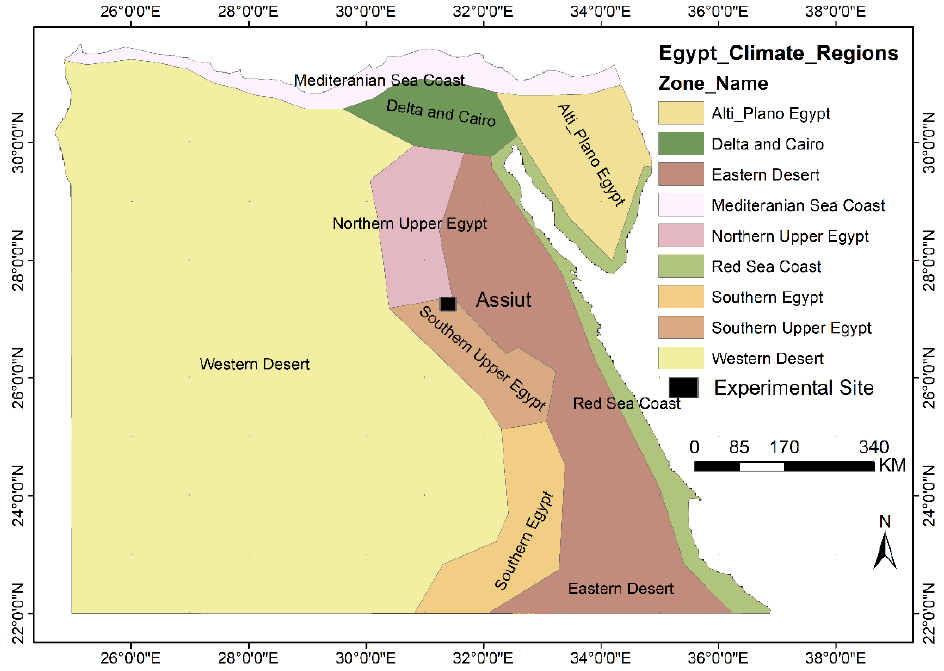
Figure 1. Experimental site and climatic zones of Egypt.